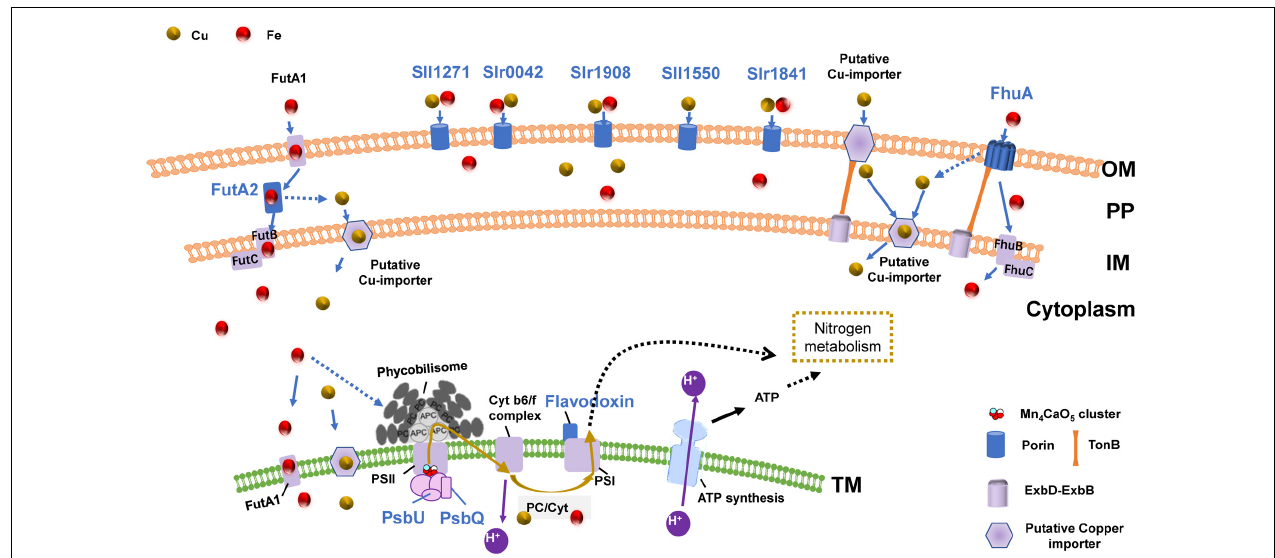
FIGURE 4 | The OM-PP-IM-TM Cu–Fe uptake system and photosynthetic electron transport chain. Proteins shown in blue: the protein expression shows significant Cu–Fe proteomic association; Solid arrow: direct influence; Dashed arrow: indirect influence.